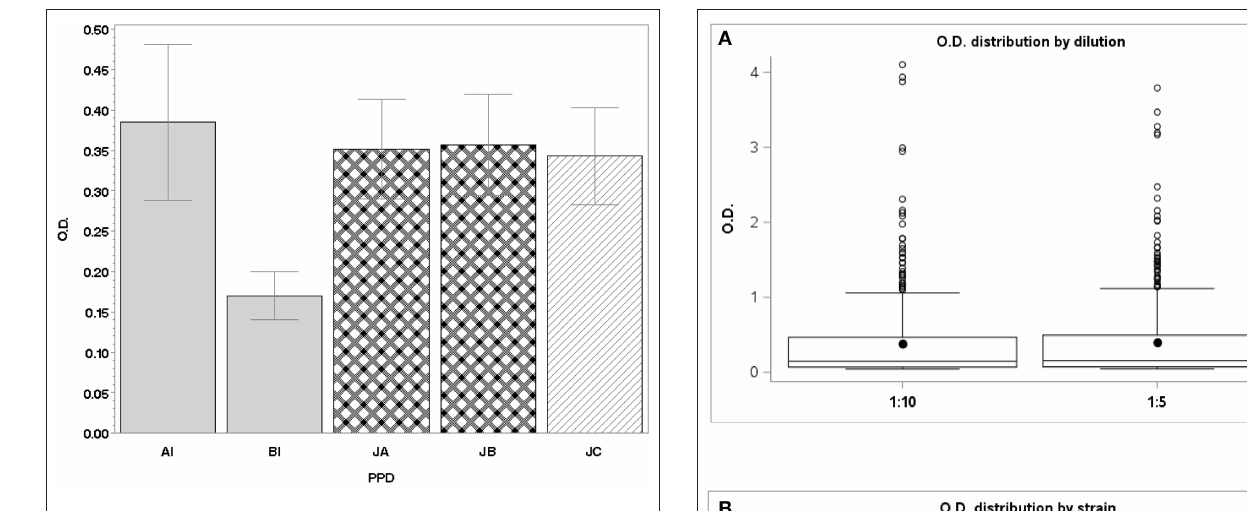
FIGURE 1 | IFN- γ production in lymphocytes of 71 PTB-positive animals. Values are expressed as the mean of the differences between the OD 450nm of PPDs and the OD 450nm of PBS ( ± SD). IFN, interferon; PTB, paratuberculosis; PBS, phosphate-buffered saline; PPD, purified protein derivative; SD, standard deviation; OD, optical density; AI, Italian avian PPD; BI, Italian bovine PPD; JA, JB, JC, Johnins produced by the three strains of MAP: A and B (field strains) and C [strain American Type Culture Collection (ATCC)